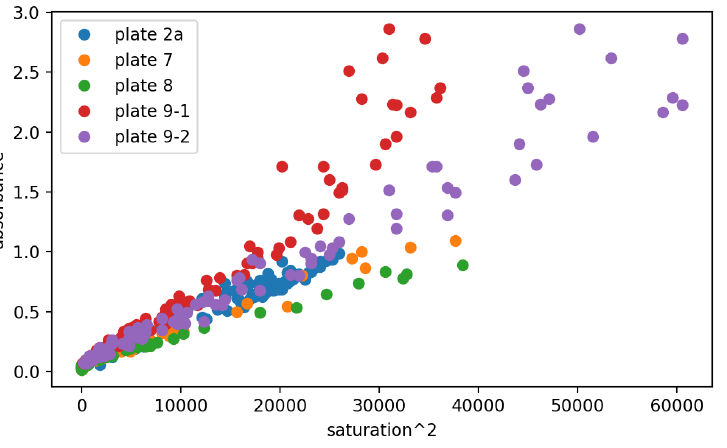
Figure 7. Effect of neighbor samples on saturation. Columns 1, 2, 5, 6, 9, and 10 are negative samples. different equipment. Images and data from Plates 7 and 8 were offered by a fellow lab at CCS-UFRJ (Center of Health Sciences), while we took different images of Plate 9 with scanners from different brands, an HP Multifunctional Advantage 3776 printer and an HP Scanjet G2410 scanner, marked as 9-1 and 9-2, respectively. As we can see from Figure 8, all results had a specific correlation between saturation and absorbance. Therefore, we recommend either running a test plate with known negative samples to determine a fixed threshold or using the negative samples in the plate to calculate the threshold.